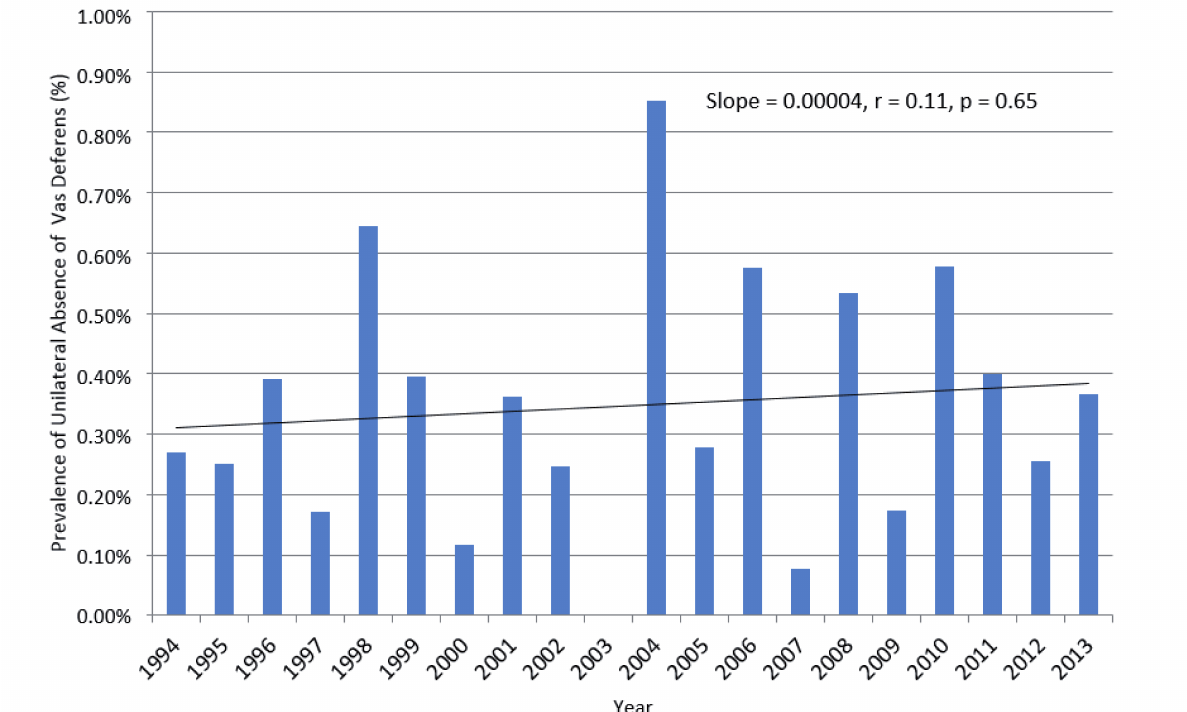
Figure 2 - Prevalence of unilateral absence of vas deferens by year